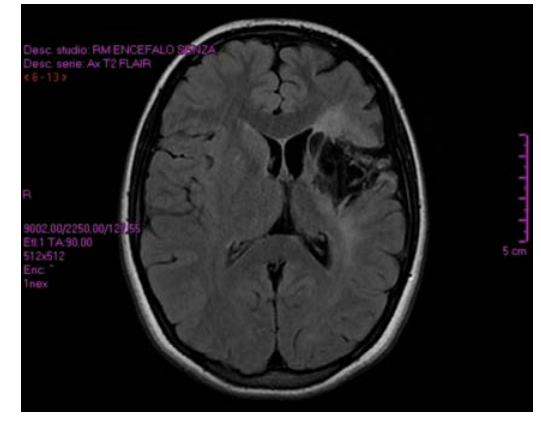
Figure 1. Magnetic resonance angiography showing a significant flow reduction of left intracranial portion of the internal carotid artery and complete absence of ipsilateral middle cerebral artery flow.